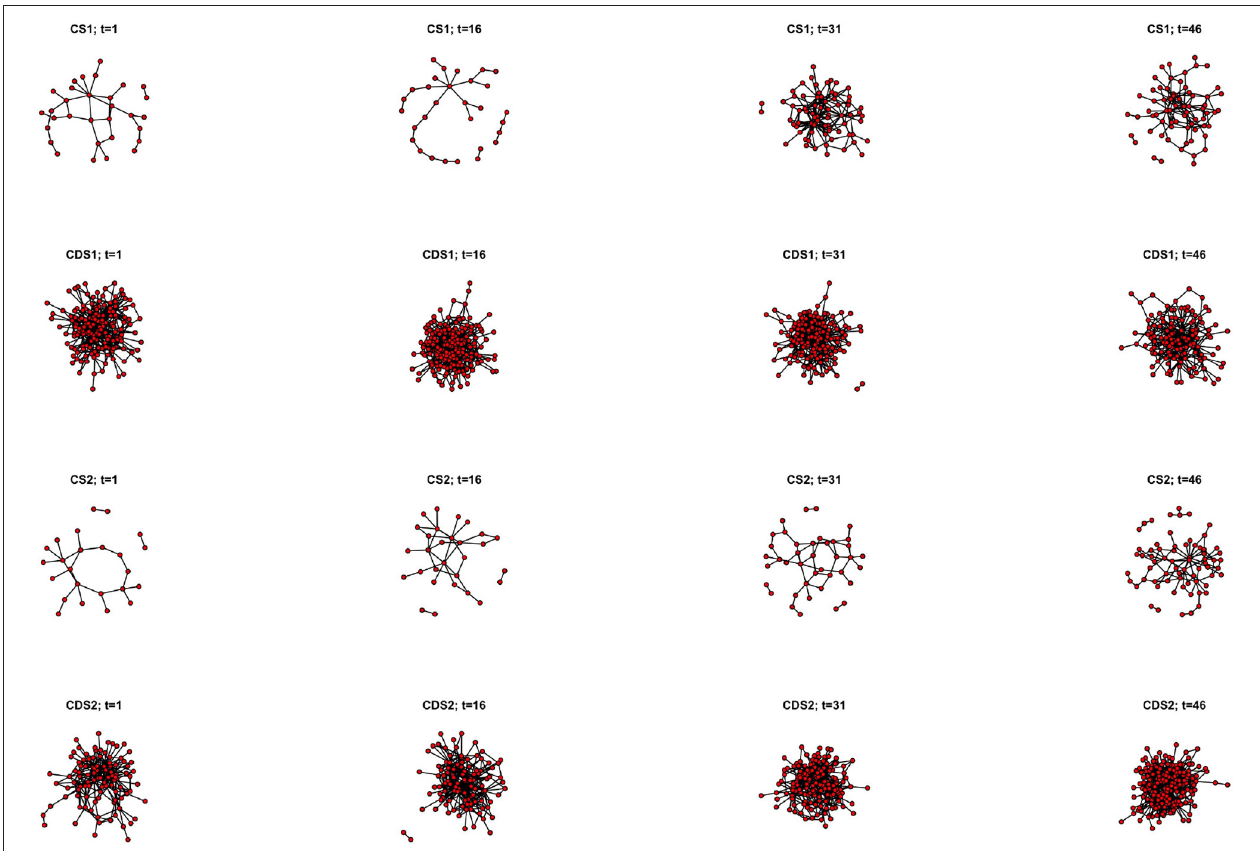
FIGURE 2 | Dynamic view of a developing verb lexicon as a network. Top row: CS of child 1; second row: CDS of child 1; third row: CS of child 2; bottom row: CDS of child 2. Each row portrays four points in the longitudinal corpus: recordings no. 1 (age 1;9.25 for Child 1, 1;8.27 for Child 2); 16 (age 1;11.6 for Child 1, 1;10.7 for Child 2); 31 (age 2;1.1 for Child 1, 2;0.0 for Child 2); and 46 (age 2;2.17 for Child 1, 2;1.23 for Child 2). The nodes of the networks are roots and inflected patterns. Links between nodes represent verb